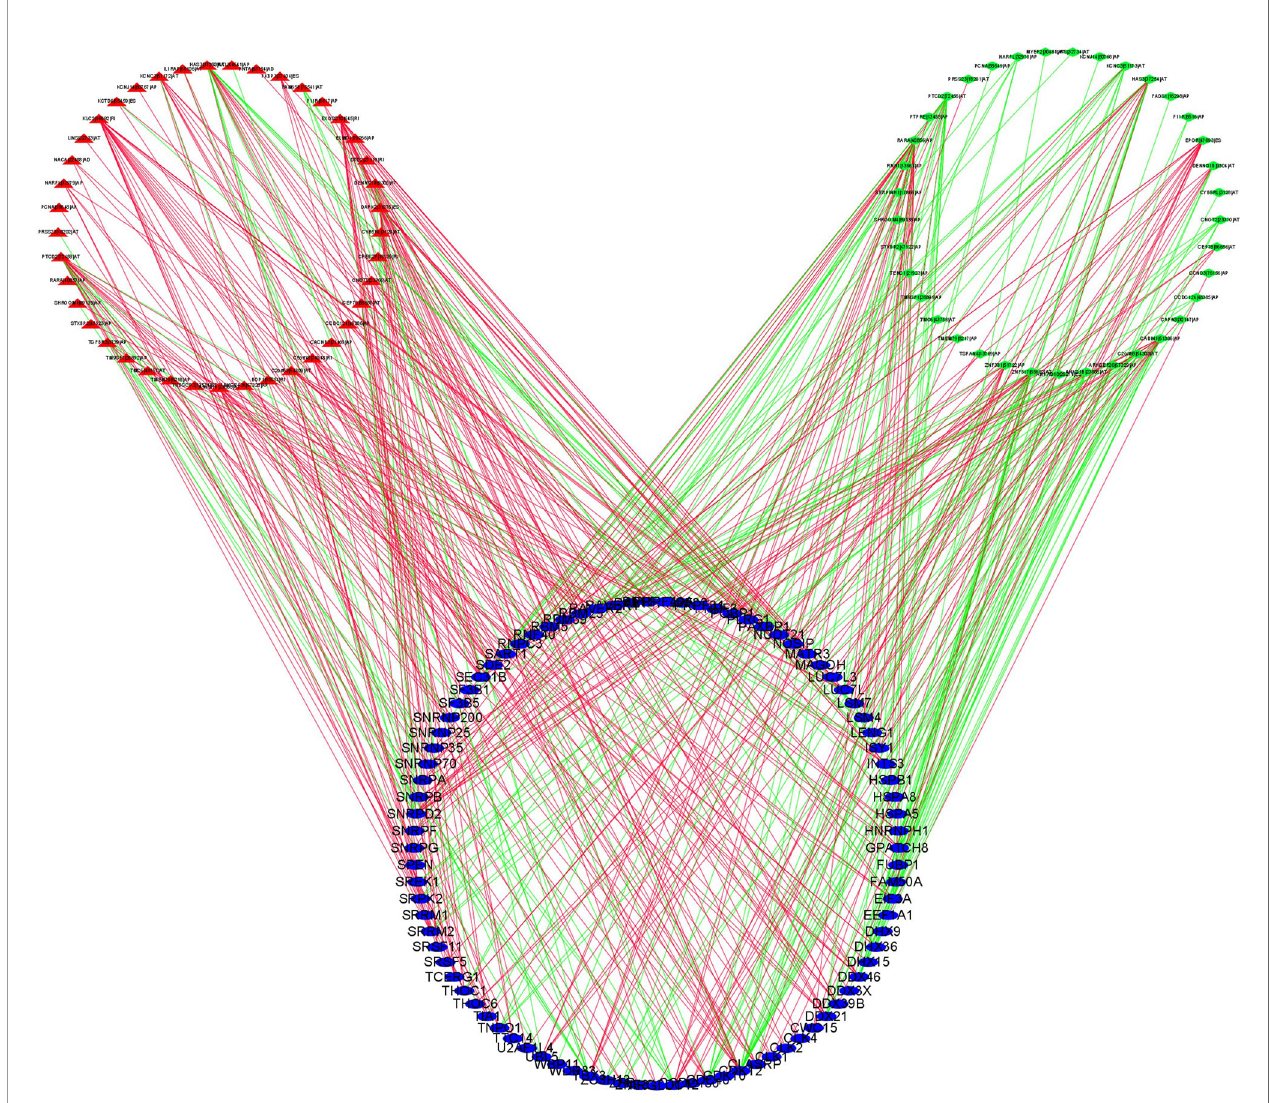
FIGURE 8 | SF-DEAS regulatory network in THCA. Forty-one OS-related high-risk AS events (red triangles) and 37 OS-related low-risk AS events (green diamonds) were positively (green lines) or negatively (red lines) regulated by 89 SFs (blue